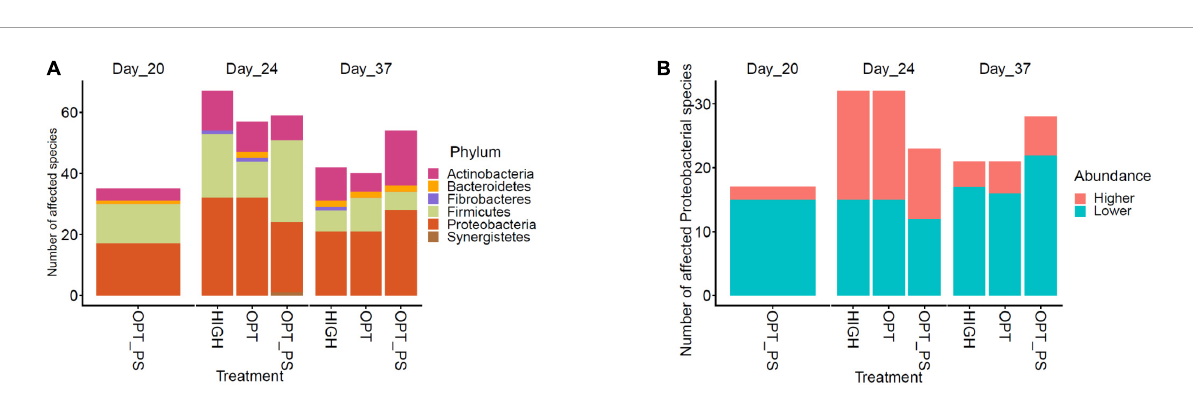
FIGURE5 Impact of synbiotic and/or enrofloxacin application on differential abundances of microbiota. The bar plot shows the number of affected taxa (A) and Proteobacterial members (either increased or decreased) (B) based on differential abundance analysis in the chicken